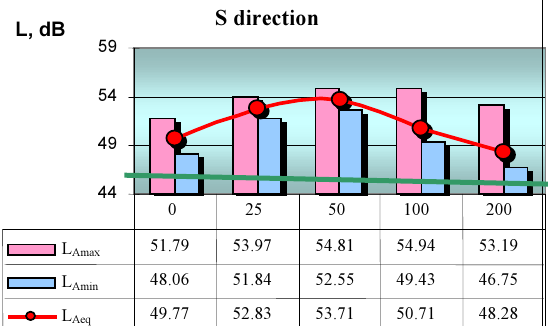
Fig. 4. Noise level dependence on measuring point’s loca- tion in respect to the wind power plant’s orientation